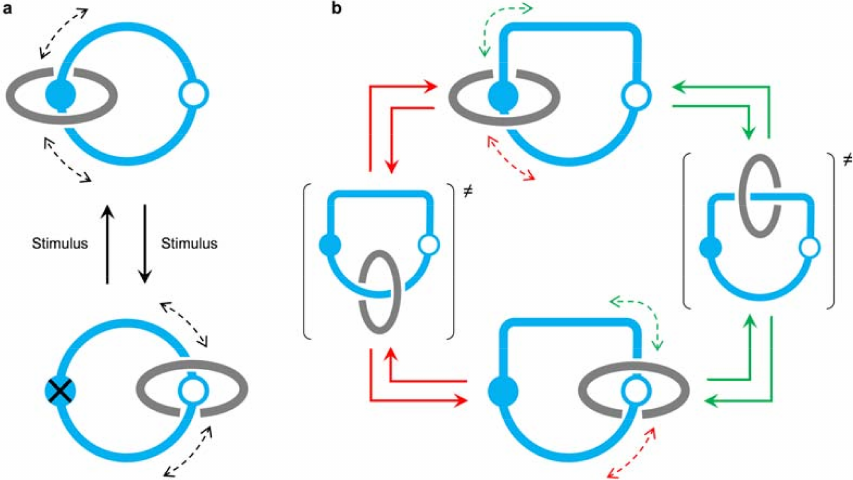
Figure 1. ( a ) In a [2]catenane containing two different recognition sites on one ring, the relative rotation of the rings is achieved upon switching off and on the primary recognition site with an external stimulus. As the clockwise and anticlockwise directions are probable equally, no repetitive unidirectional circumrotation can be obtained. ( b ) In a bistable [2]catenane with an oriented ‘track’ ring, the clockwise and anticlockwise rotation directions are not equivalent. This is a key requirement for the construction of catenane rotary